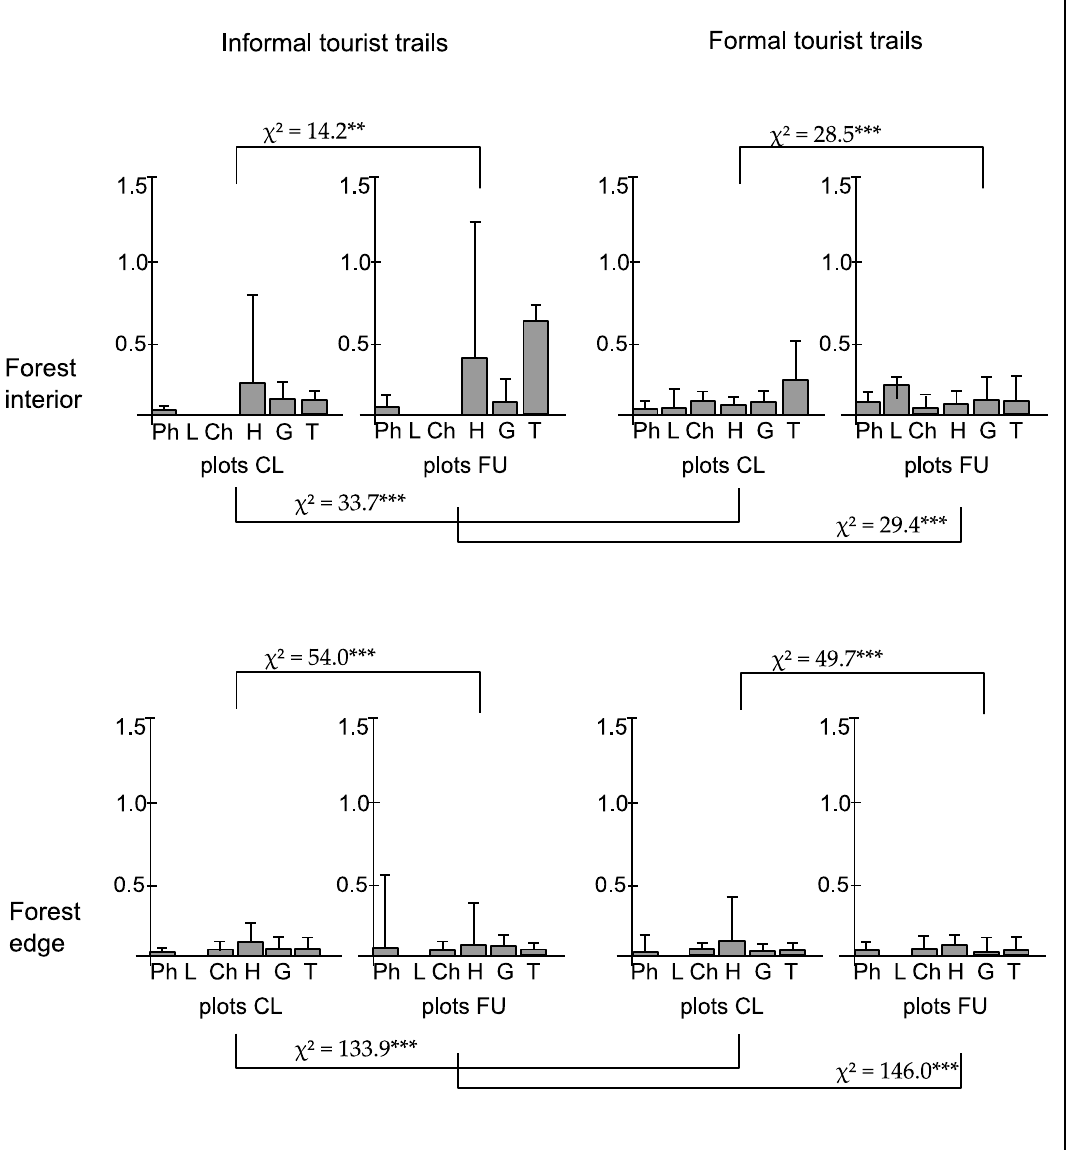
Figure 9. The mean cover-abundance degree of species (±SD) representing phanerophytes (Ph), lianas (L), chamaephytes (Ch), hemicryptophytes (H), geophytes (G), and therophytes (T) per plot in closer (CL) and further (FU) plots located along informal (width < 50 cm) and formal (width > 150 cm) tourist trails within the forest interior and forest edge sites. The statistical significance level is explained in Figure 2.